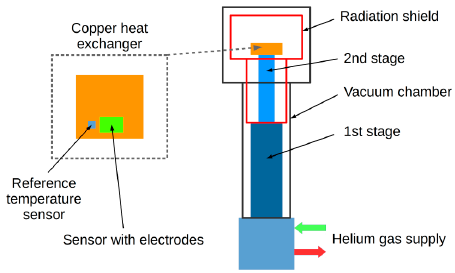
Figure 6. Scheme of cooling circuit.